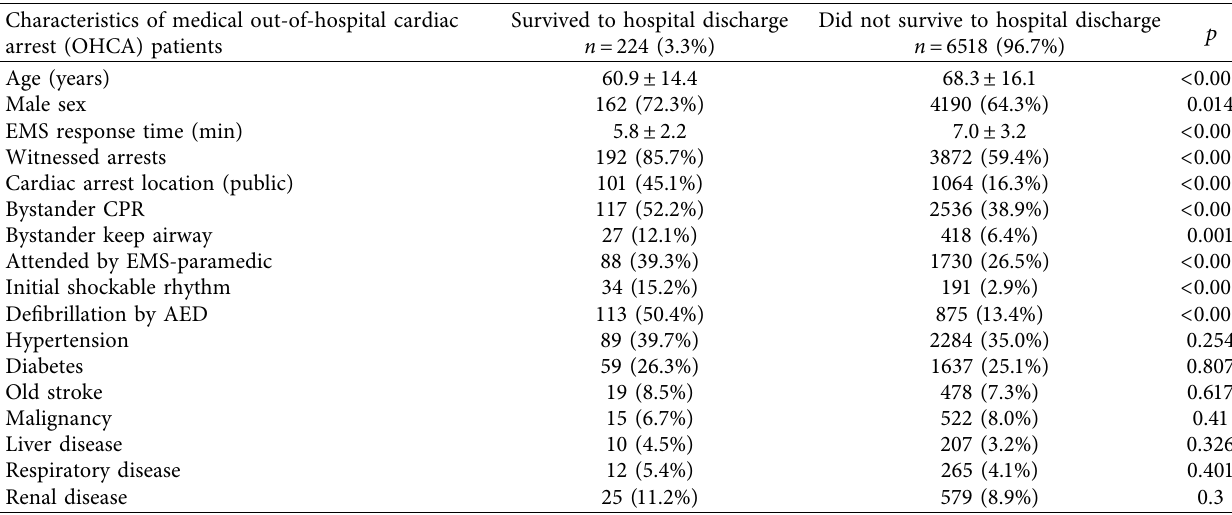
Table 1: Demographic characteristics, comorbidities, and prehospital factors of 6742 medical out-of-hospital cardiac arrest patients. Characteristics of medical out-of-hospital cardiac